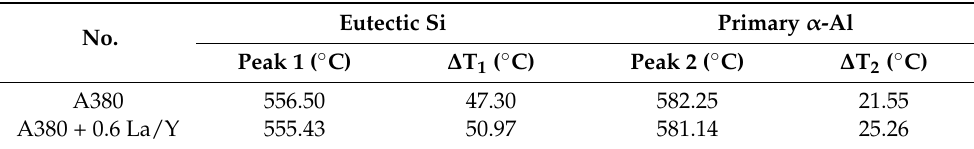
Figure 9. DSC curves for the La/Y-free and La/Y-contained A380 alloys. Table 3. The Results of DSC Analysis.